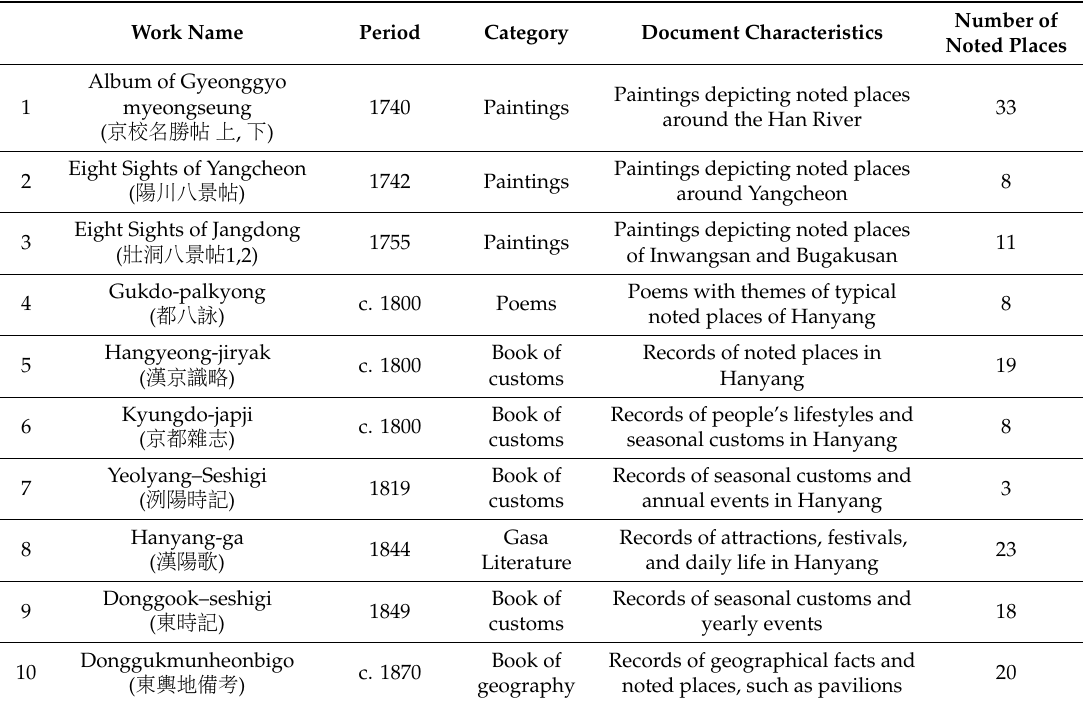
Table 1. List of ten old